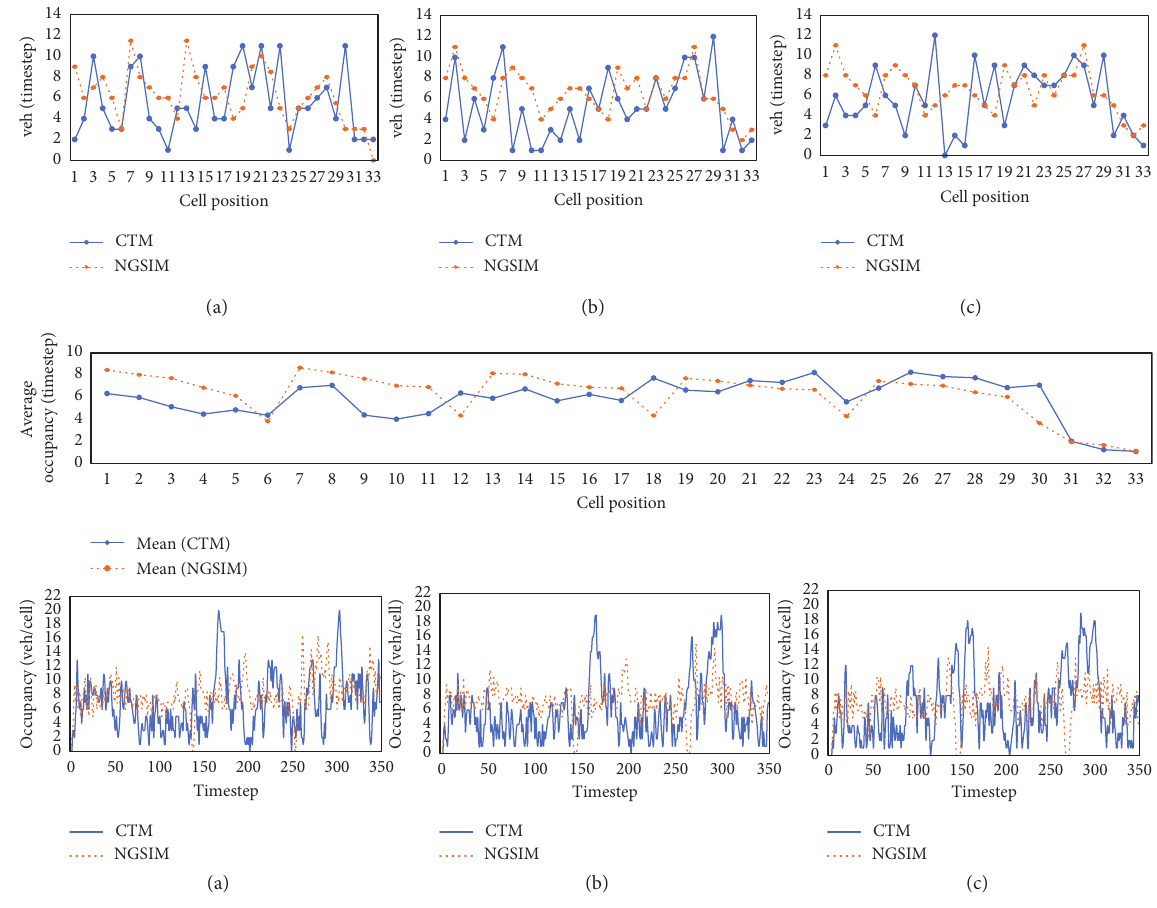
Figure 16: Validation of CTM with US-101 for case